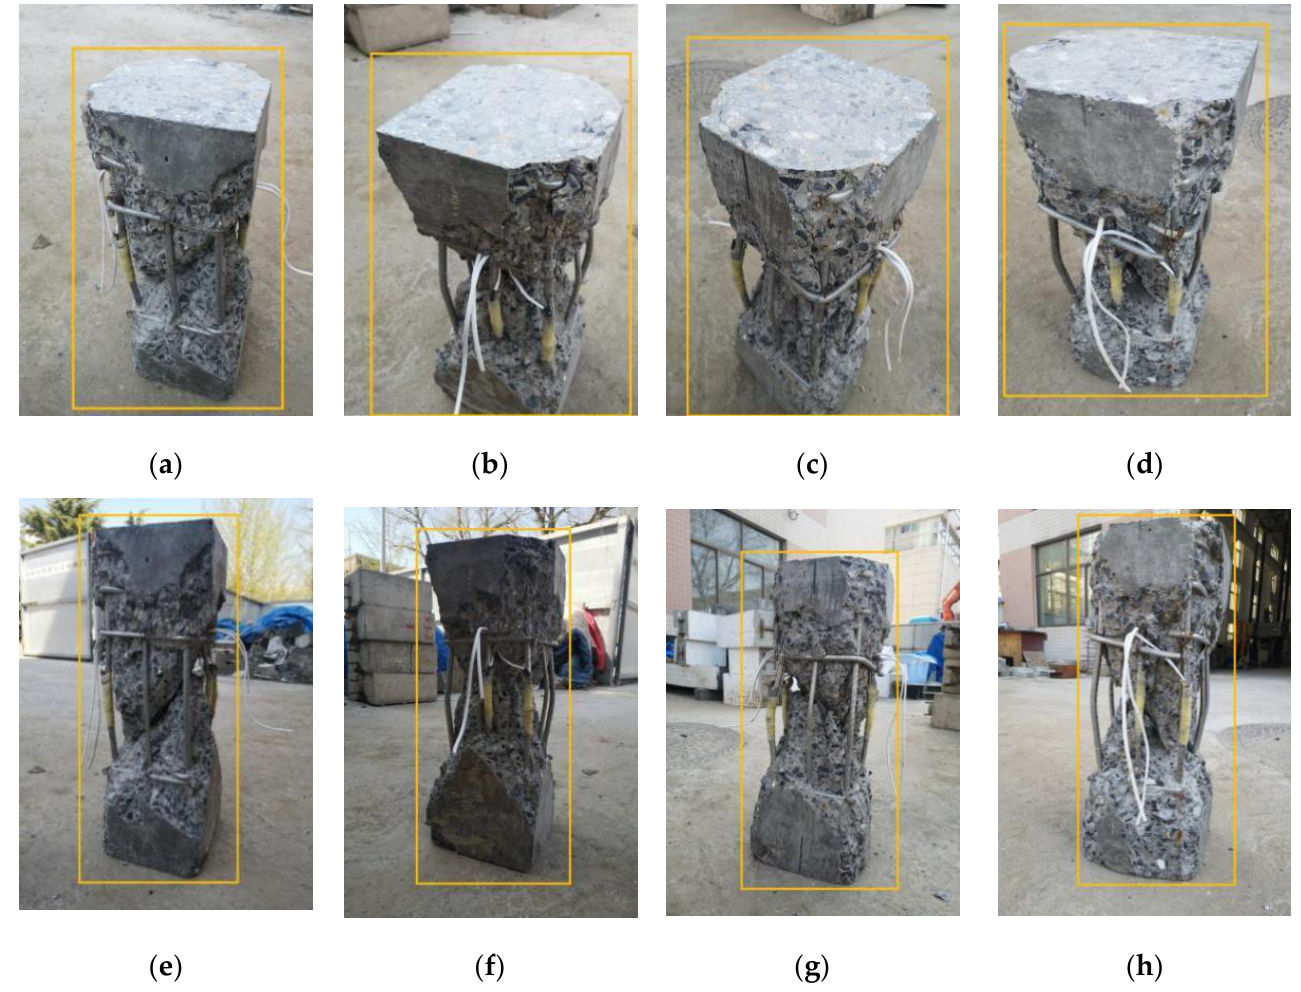
Figure 3. Framework selection diagrams that roughly cover all aspects of the structure.